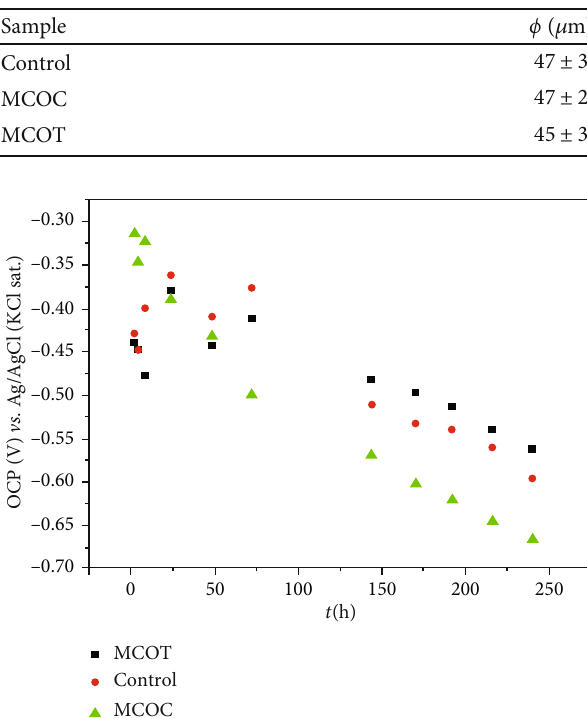
Figure 11: Compilation of OCP data up to 240 hours: the measurements on the plate that contain (a) 3% (m/m) MCOT are represented by the black squares, (b) those that contain 3% (m/m) MCOC are represented by green triangles, and (c) the measurements of the control plate are represented by red